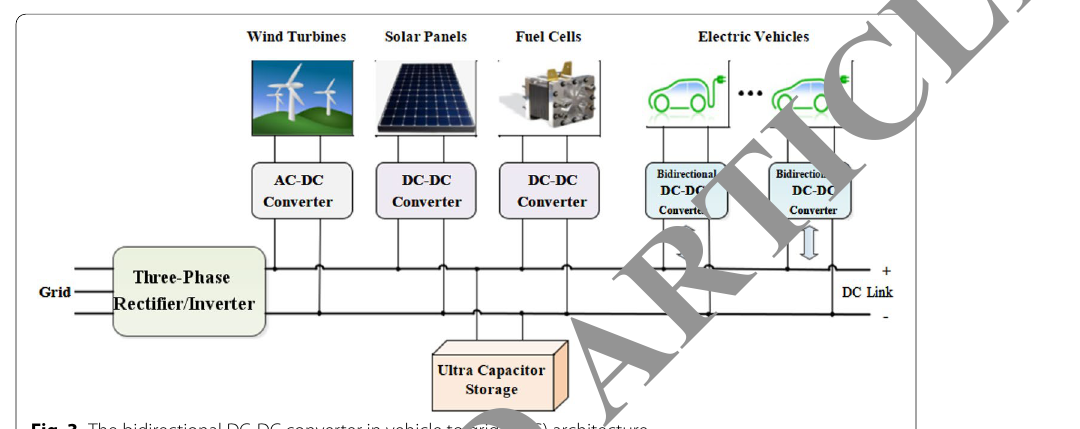
Fig. 3 The bidirectional DC-DC converter in vehicle to grid (V2G)